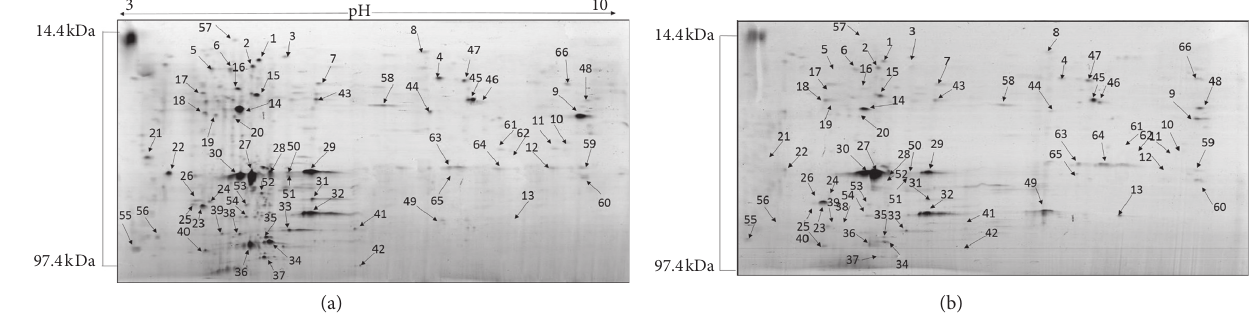
Figure 1: 2-D gels of differentially expressed proteins of P. expansum treated with sterile distilled water and M. guilliermondii . (a) P. expansum protein expressed after treatment with sterile distilled water. (b) P. expansum protein expressed after treatment with M. guilliermondii